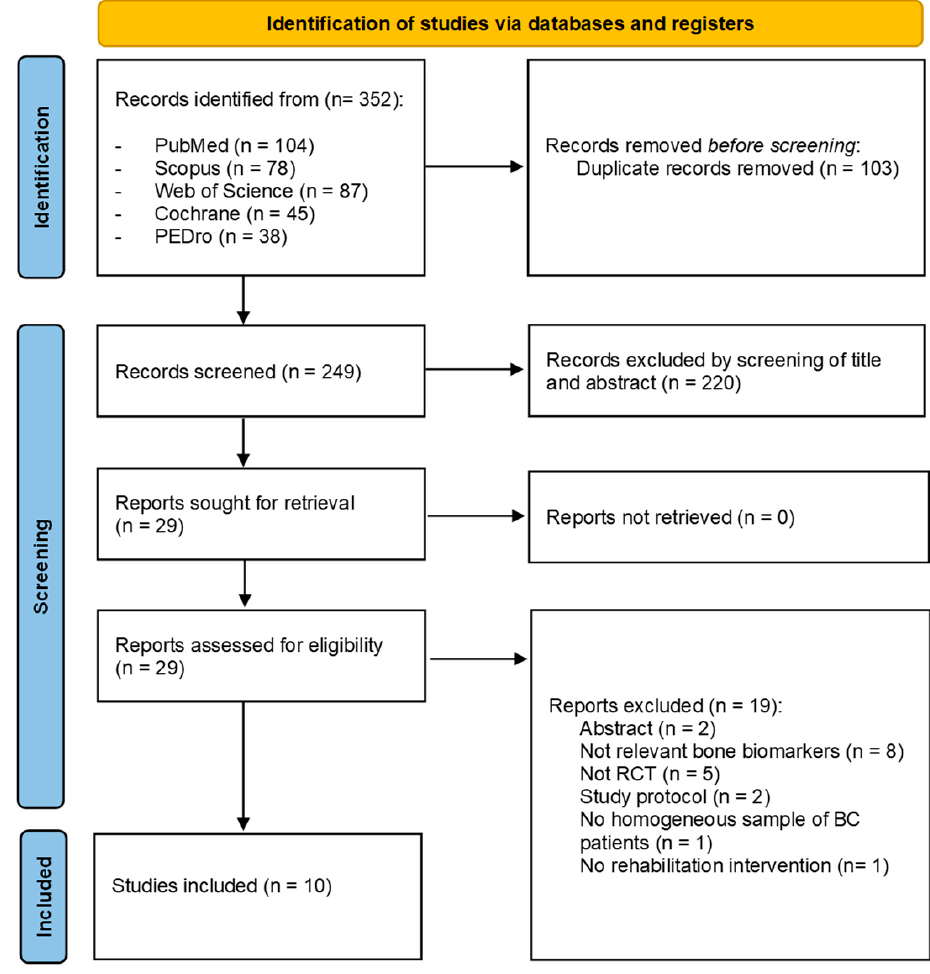
Figure 1. PRISMA 2020 flow diagram.